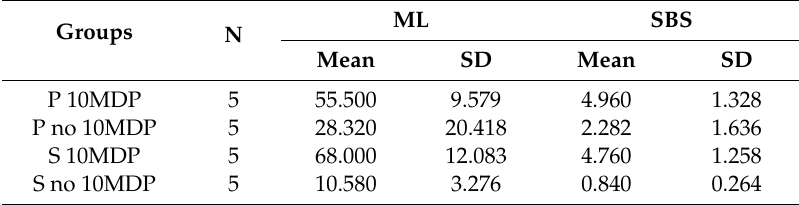
Table 4. Mean and standard deviation of the analyzed variables for each group.